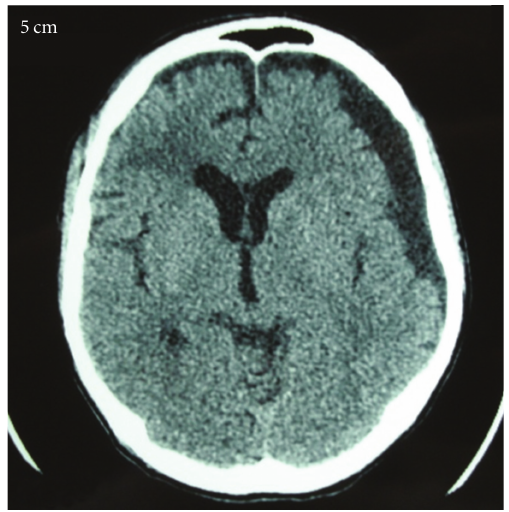
Figure 1: CT scan showing an increasing subdural fluid collection with mild mass e ff ect and some e ff acement of lateral ventricle.